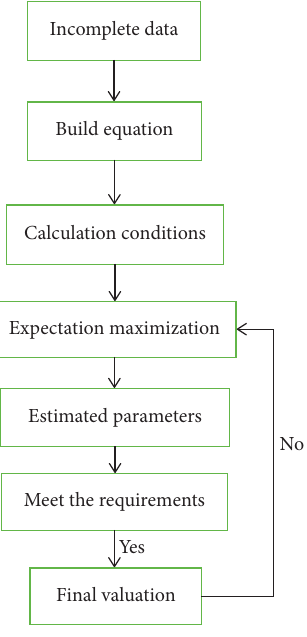
Figure 6: Flow chart of the EM algorithm.